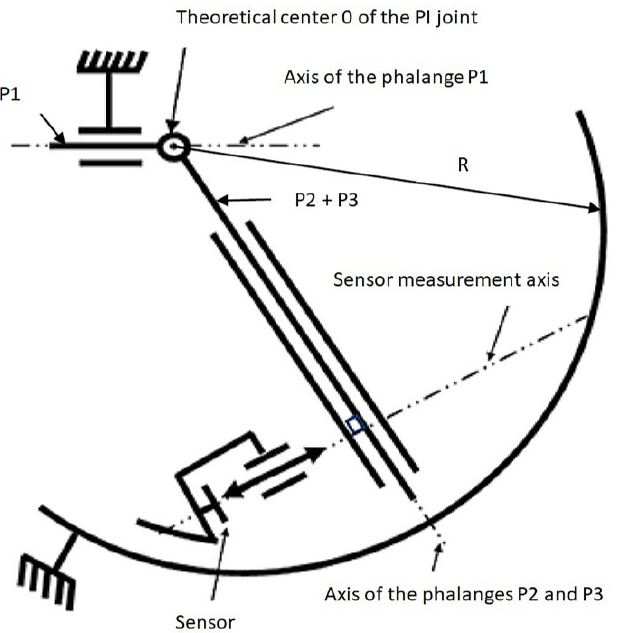
Figure 1. Kinematic diagram of the force measurement system for the finger